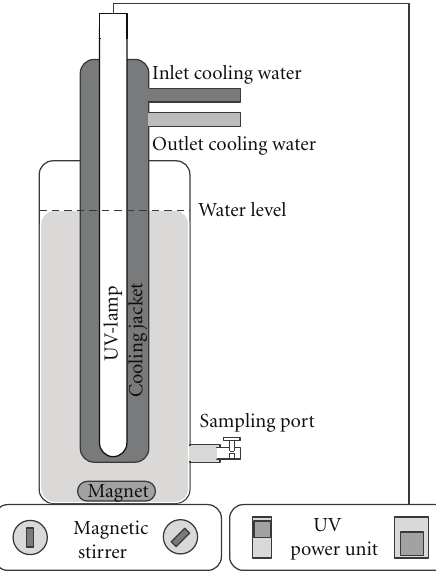
Figure 1: Schematic view of the UV-reactor used in the photo- Fenton